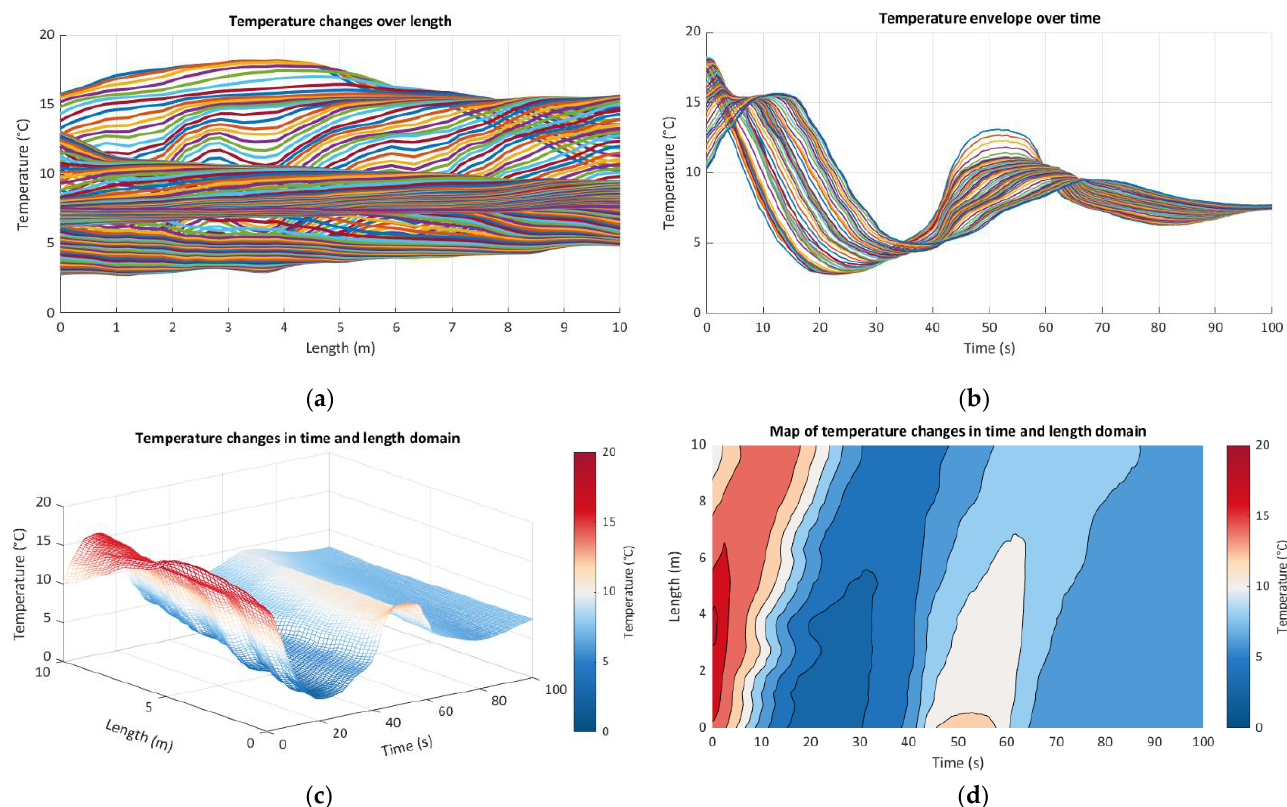
Figure 13. Example dynamic DFOS results showing the process of equalizing the temperature along the sensor: ( a ) in length domain; ( b ) in time domain; ( c ) spatial visualization in both time and length domains; ( d ) temperature map.